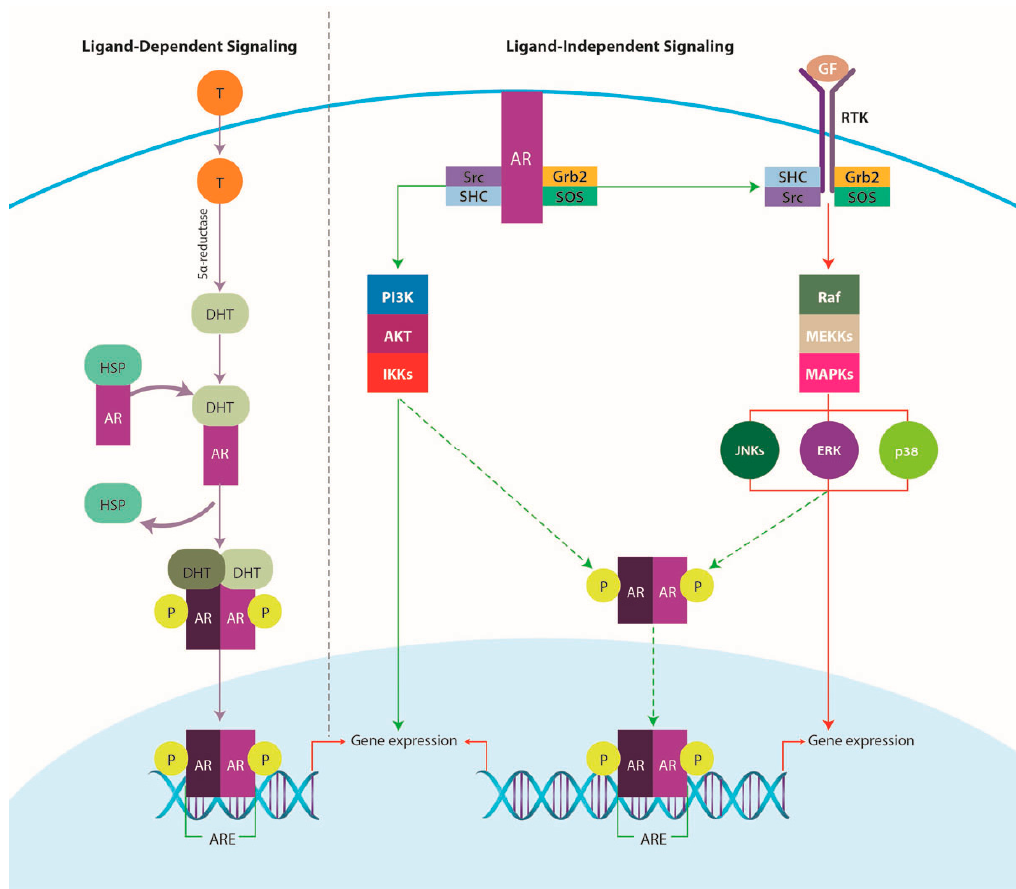
Figure 6. Androgen receptor (AR) signaling pathway. Ligand dependent and independent mechanisms. T: testosterone; DHT: 5- α dihydrotestosterone; HSP: heat shock protein; GF: growth factors; RTK: receptor tyrosine kinase.